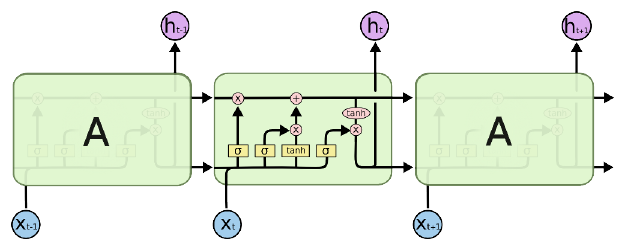
Figure 3. Recurrent Neural